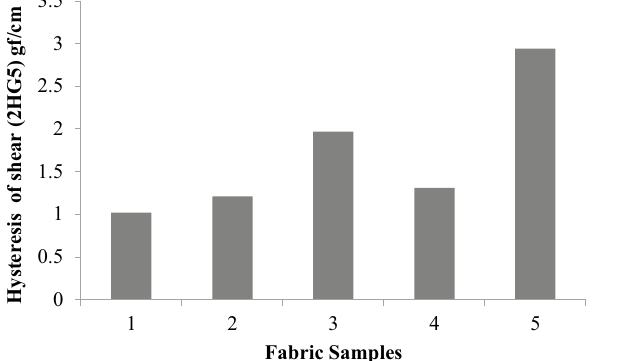
Figure 11. Hysteresis of shear (2HG5) of fabrics.